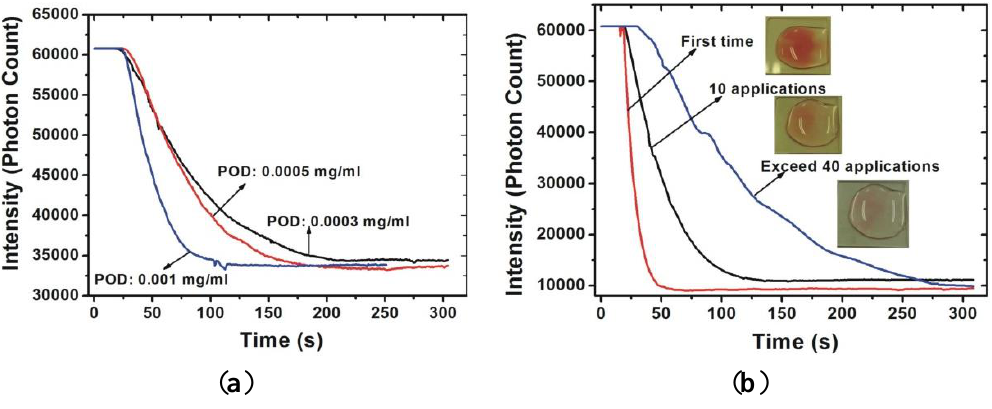
Figure 9. Reliability of the proposed sensor: ( a ) transmittance-time response curves with various POD concentrations; and ( b ) transmittance-time response curves for various application numbers measured by the proposed sensor with POD concentration of 0.001